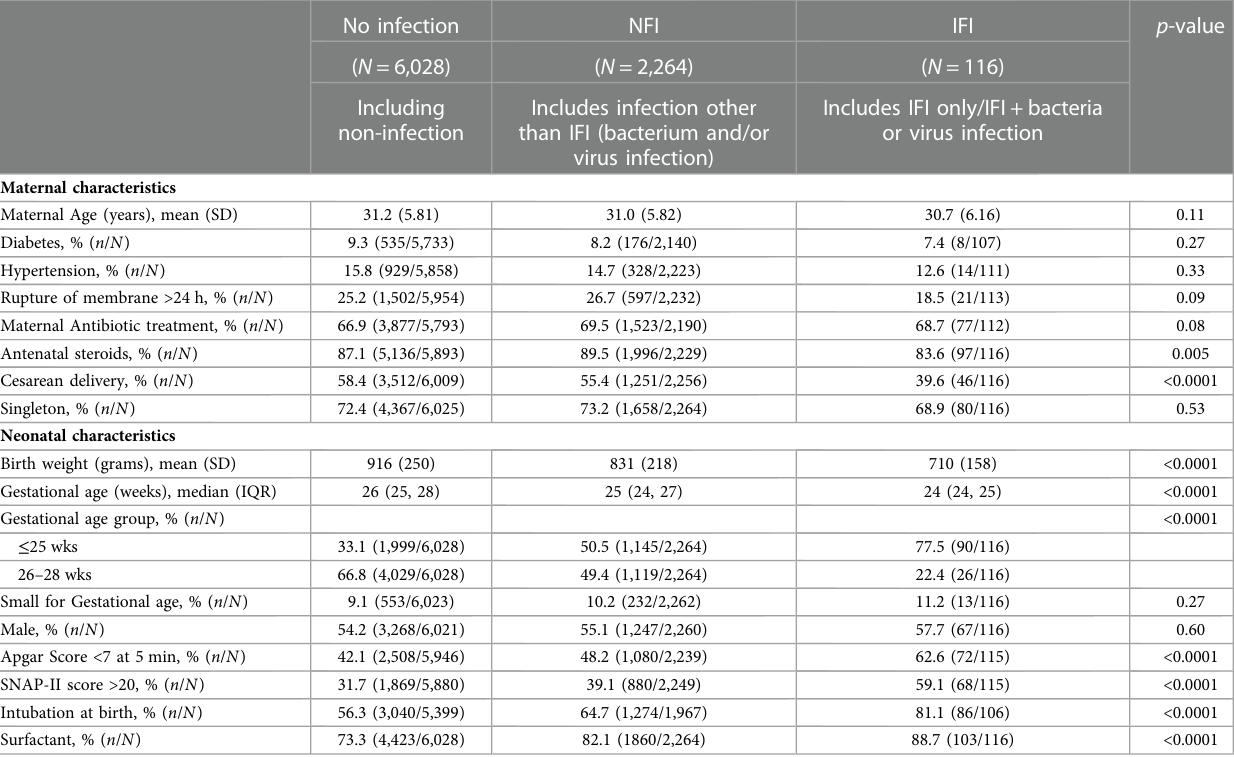
No infection NFI IFI p -value ( N = 6,028) ( N = 116) Including Includes infection other Includes IFI only/IFI + bacteria non-infection than IFI (bacterium and/or or virus virus infection)